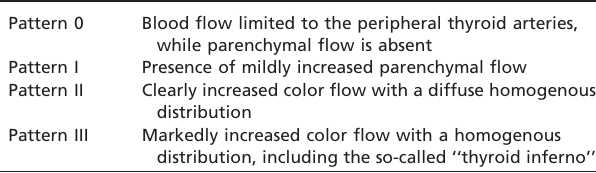
Table 3 - Grading of the gray-scale findings and distribution of patients within the grades. (Note: we have added Grade 0 to the original grading system created by Sostre and